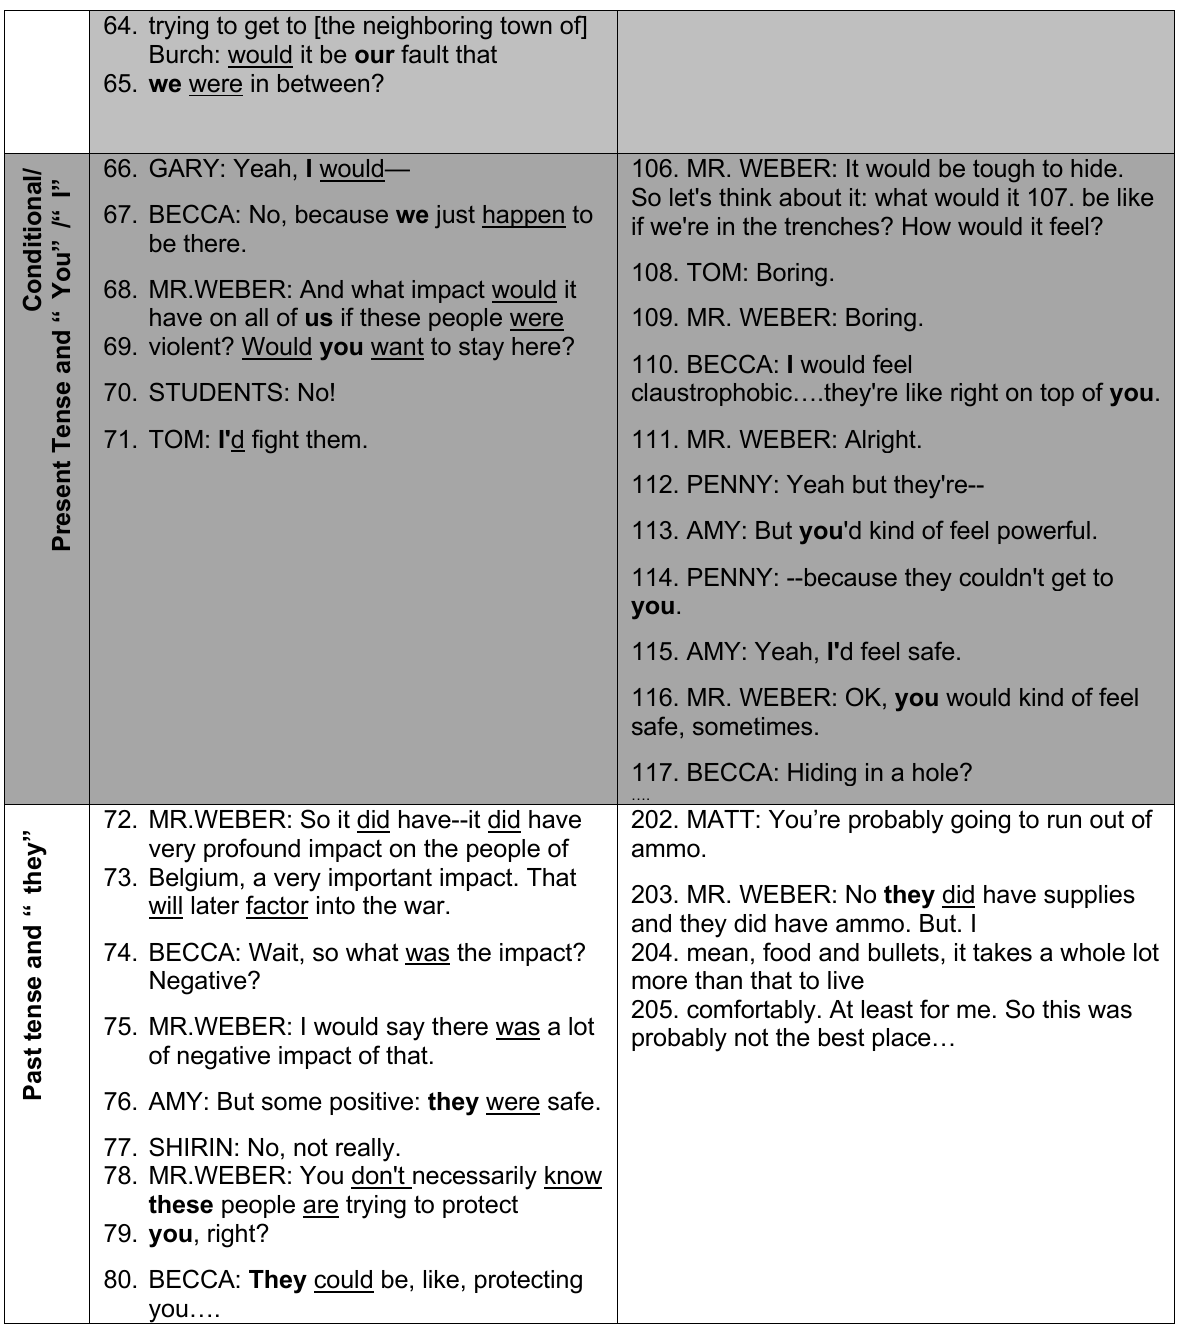
Figure 2. Shifts in verb tense and pronoun use during dialogic, whole-class discussions of the Invasion of Talbott/Belgium and of Football/Trench Warfare. (Verbs are underlined and pronouns bolded; shading indicates progression toward more present, personal uses of